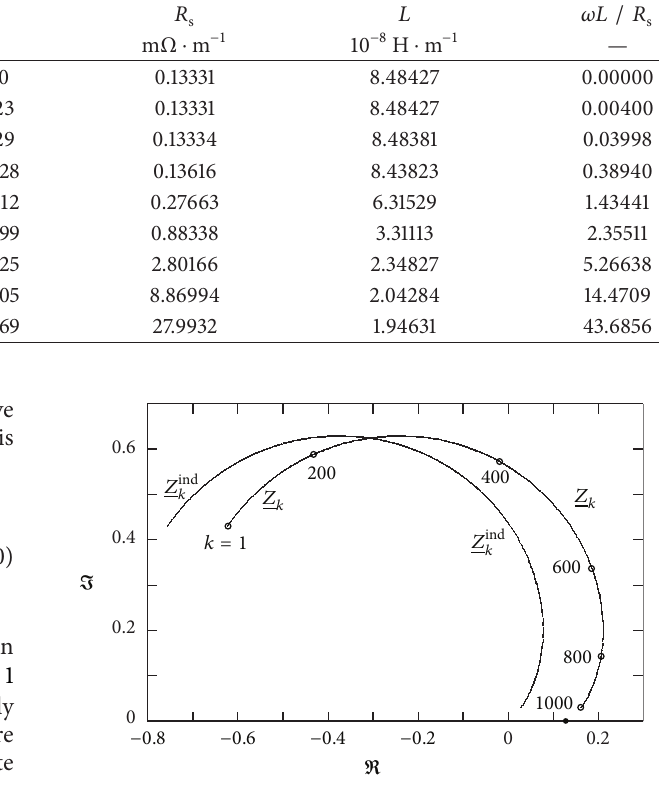
Figure4:Equivalentandinducedimpedances 𝑍 𝑘 and 𝑍 ind 𝑘 ofpartial loops in Gaussian plane in Example 1, for 𝑓 = 10 3 Hz, 𝑛 = 1000 . Impedance parts are expressed in Ω ⋅ m −1 . On horizontal axis, the value of resistance-1 of partial loop is marked by ∙